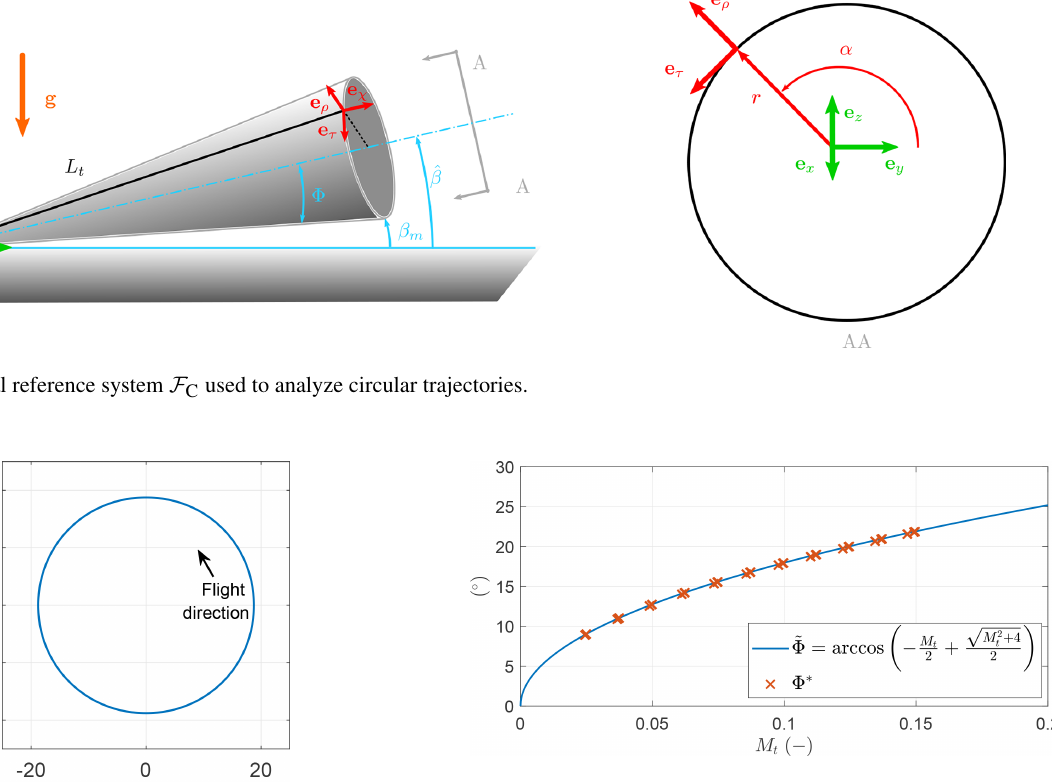
Figure 7. Optimal opening angles (cid:56) ∗ (x) found by solving multiple OCPs and analytical expression (–) as a function of the modified non-dimensional mass parameter M t